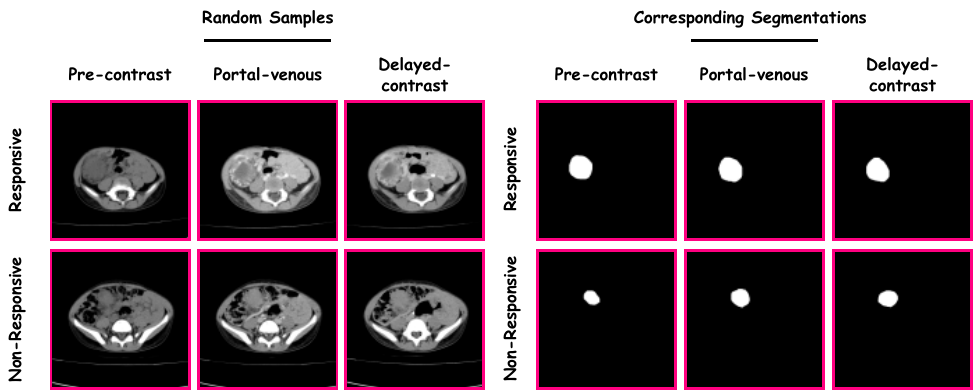
Figure 2. Samples from the dataset and their corresponding